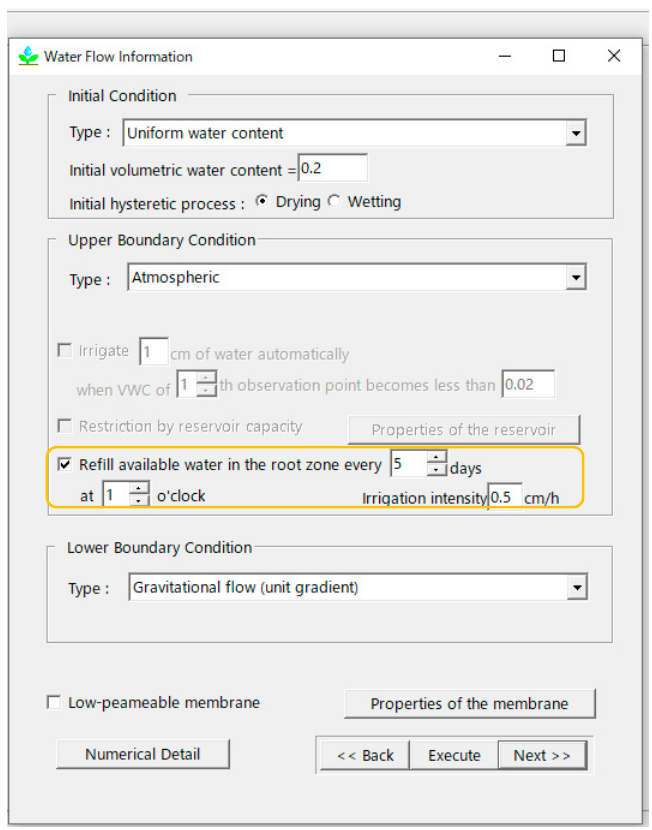
Figure 2. Screen shot of the user interface showing the newly added options for refilling the soil profile as surrounded by a yellow rectangle.